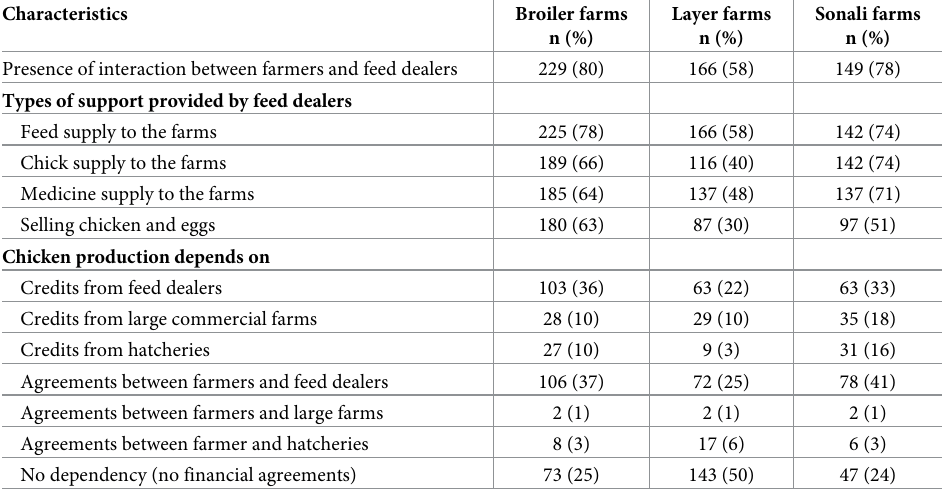
Table 6. Nature of interaction between farmers, feed dealers and other associated partners.